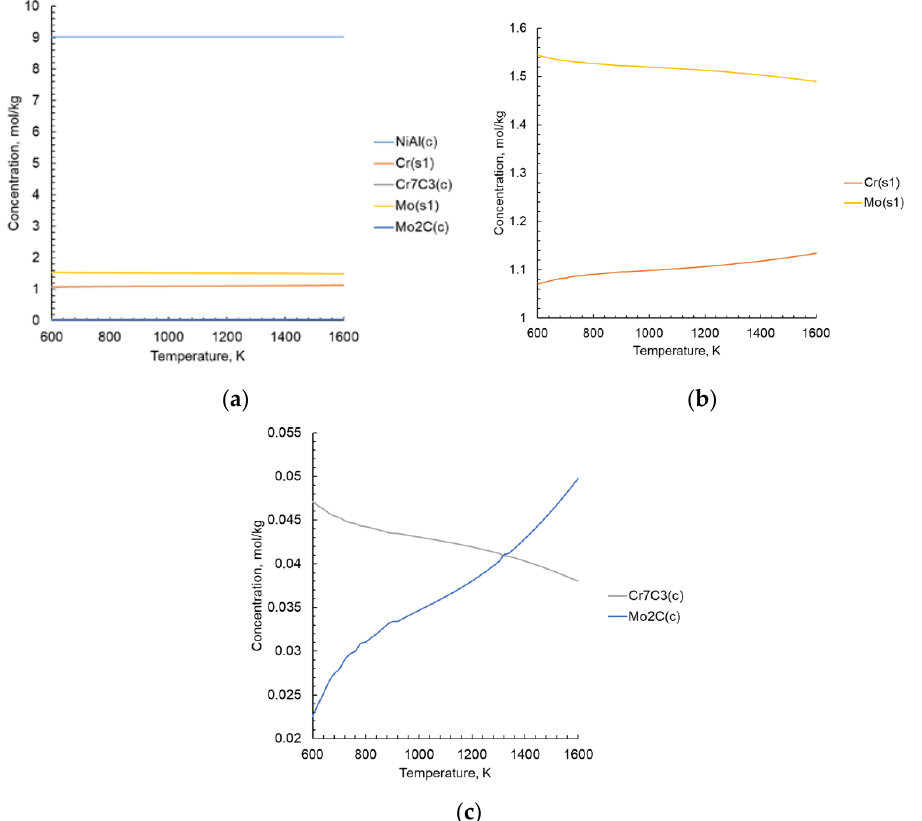
Figure 5. Results of calculating the equilibrium phase composition in the NiAl-Cr-Mo-C system: ( a ) all phases, ( b ) solid solution (s1) components, ( c ) carbide phases.